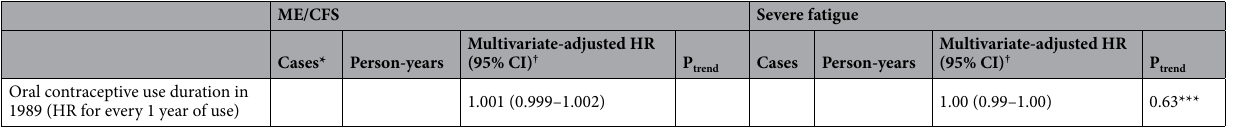
Table 3. Hazard ratio by risk factor, comparing ME/CFS to severe fatigue. HR, hazard ratio. † Adjusted simultaneously for age, physical activity (quartiles), body mass index (BMI) (< 18.5, 18.5–24.9, 25–29.9, ≥ 30), and smoking status (never, past, current), with the exception of analyses of physical activity [metabolic equivalents (METs)], BMI and smoking which are not adjusted for the exposure in question. *The total number of cases of CDC characterized ME/CFS was 102, but because of missing values, the numbers for some variables do not add up to 102. **Hormone therapy use and menopausal status additionally adjusted for each other. Hormone therapy models adjusted for menopausal status and menopausal status models adjusted for hormone therapy use. @ Number of cases is smaller for caffeine and alcohol intake than for other variables, because caffeine and alcohol data was collected in 1991. ***Because of the categorical nature of the variables, we give the Wald p-value provided by the Cox model indicating whether the HR comparing the category in question is significantly different from 1, relative to the reference.